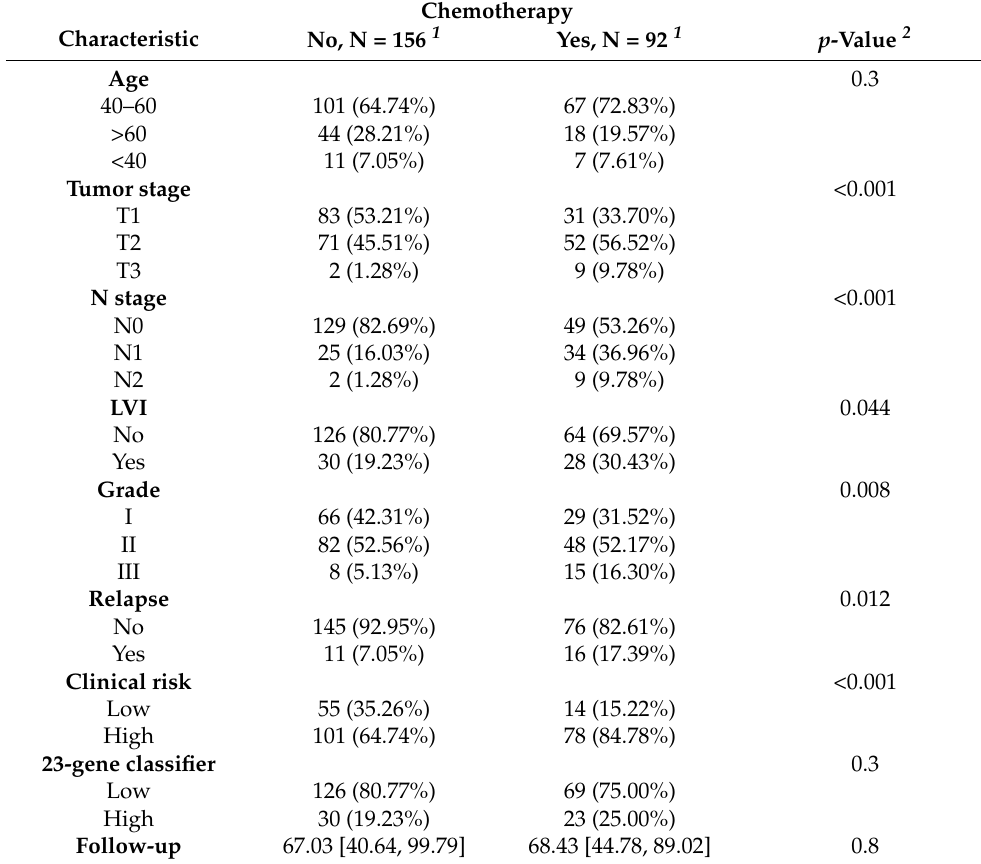
Table 2. Basic clinical characteristics among patients with/without